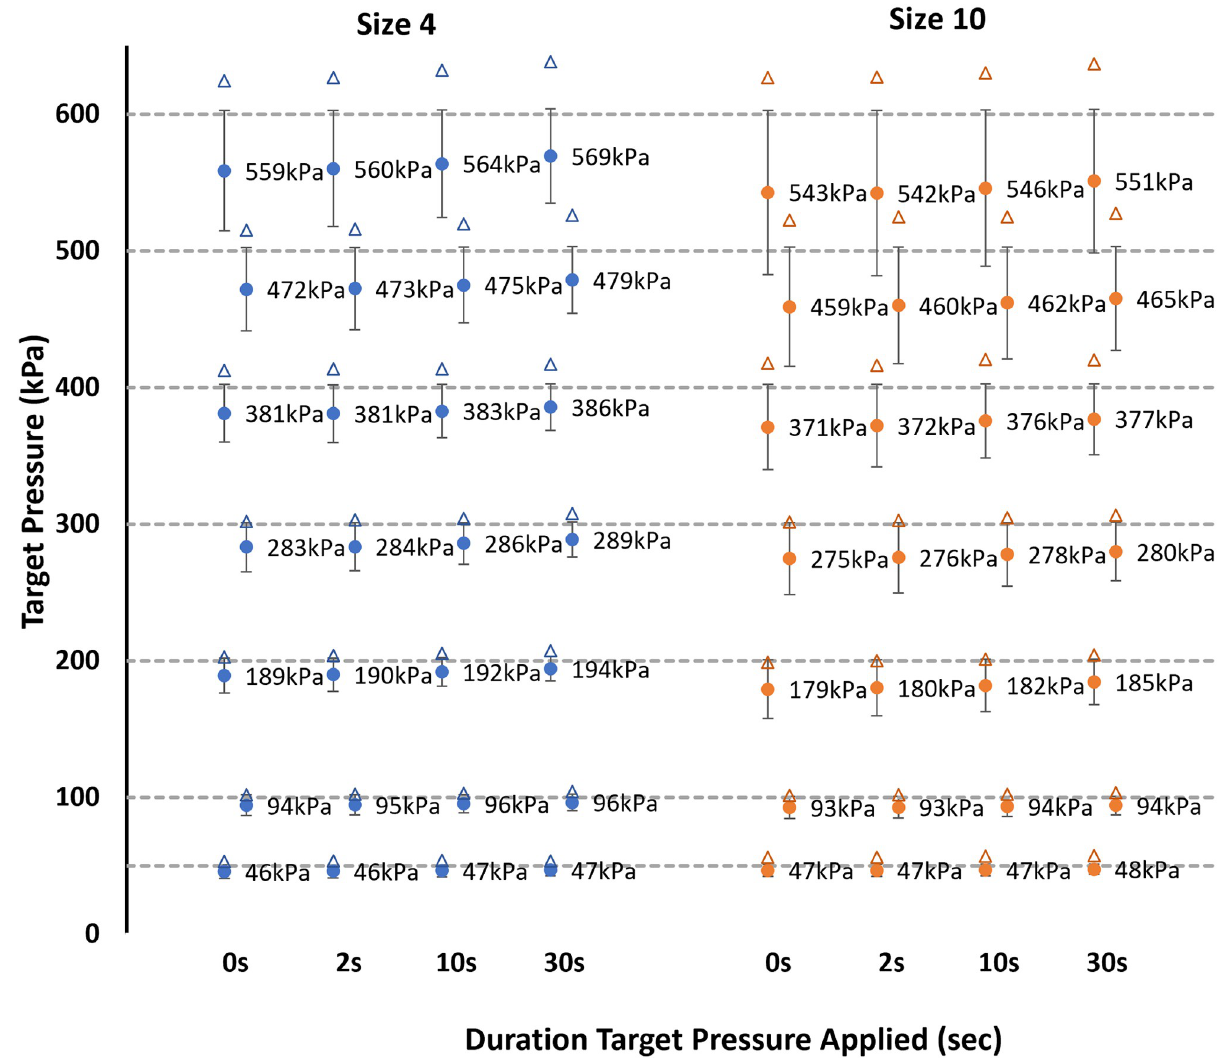
Fig 3. Peak and mean pressure values recorded over 0, 2, 10 and 30 s for the 7 target pressures for both insoles on day one. Where circles mark the mean pressure data, error bars denote the Root Mean Square Error (RMSE) across all individual sensels about the mean recorded value and the triangle marks the peak pressure